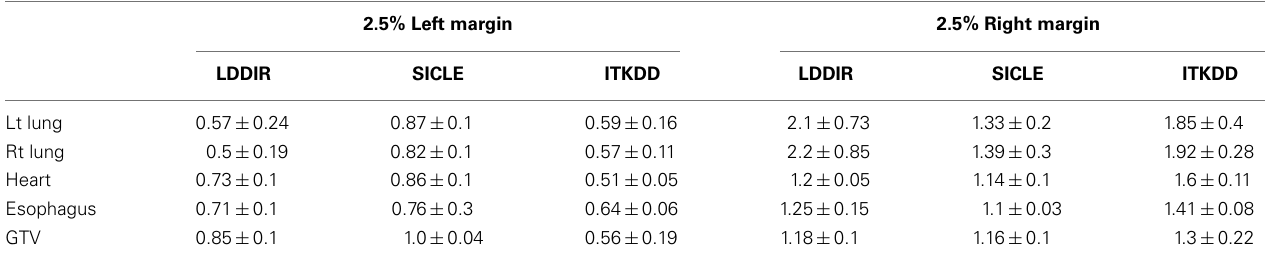
Table 3 |Two sided 2.5% volume boundary of differential Jacobian volume histogram for 13 patients .